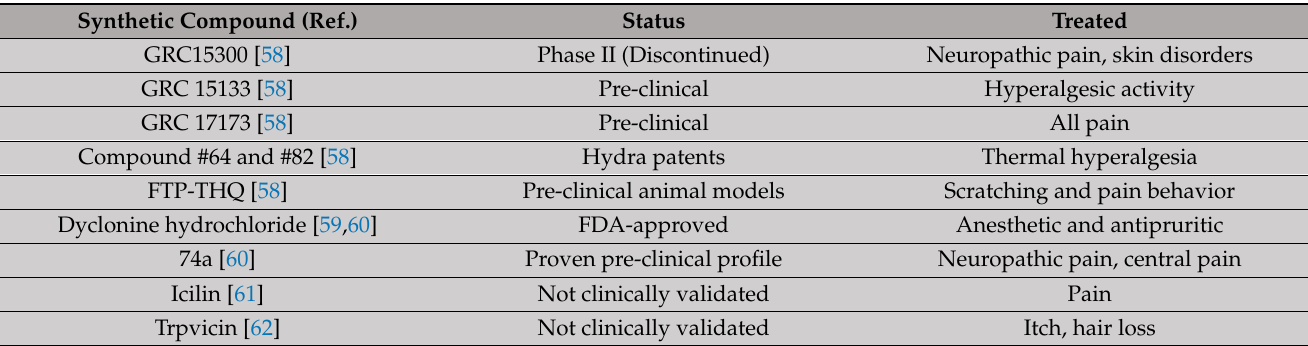
Table 1. Synthetic TRPV3